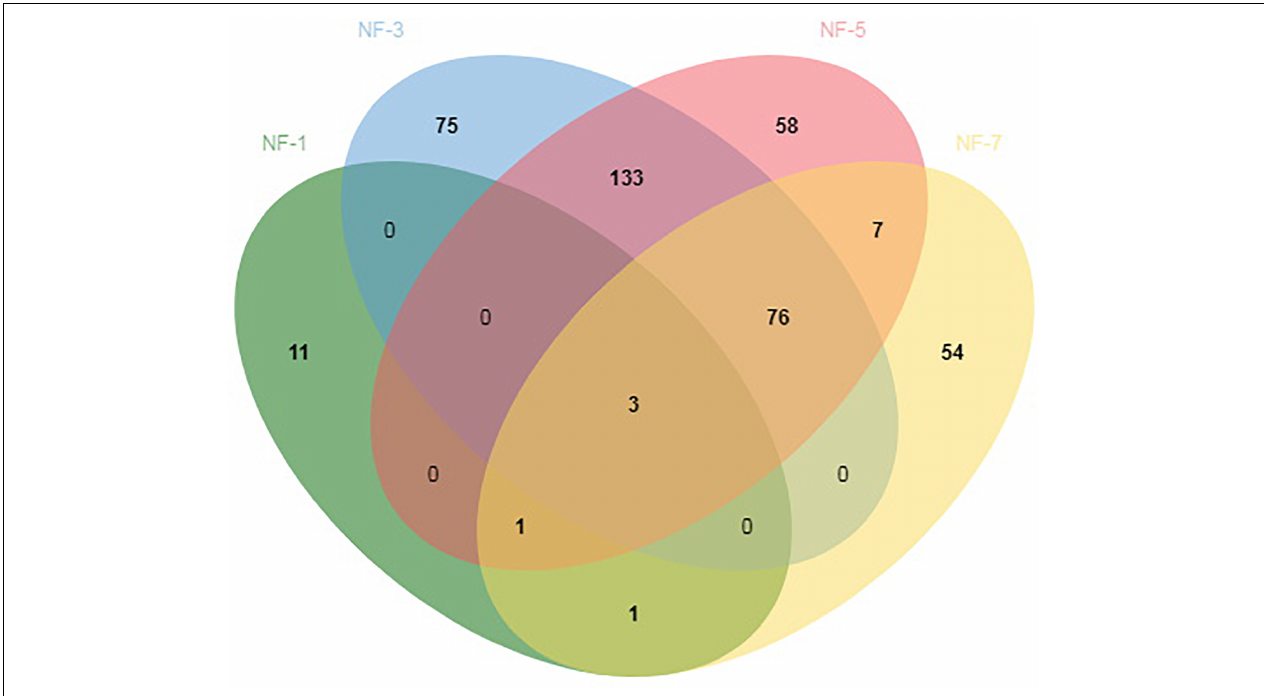
FIGURE 1 | Analysis of amplicon sequence variants (ASVs) shared by different groups. Numbers below groups indicate the number of ASVs within each sector. The number of species in NF-1 is 15; the number of species in NF-3 is 287; the number of species in NF-5 is 278; the number of species in NF-7 is 142; the number of species shared between NF-1 and NF-3 is 3; the number of species shared between NF-1 and NF-5 is 3; the number of species shared between NF-1 and NF-7 is 5; the number of species shared between NF-3 and NF-5 is 212; the number of species shared between NF-3 and NF-7 is 79; the number of species shared between NF-5 and NF-7 is 87; the total shared richness is 3; and the total richness of all the groups is 419.